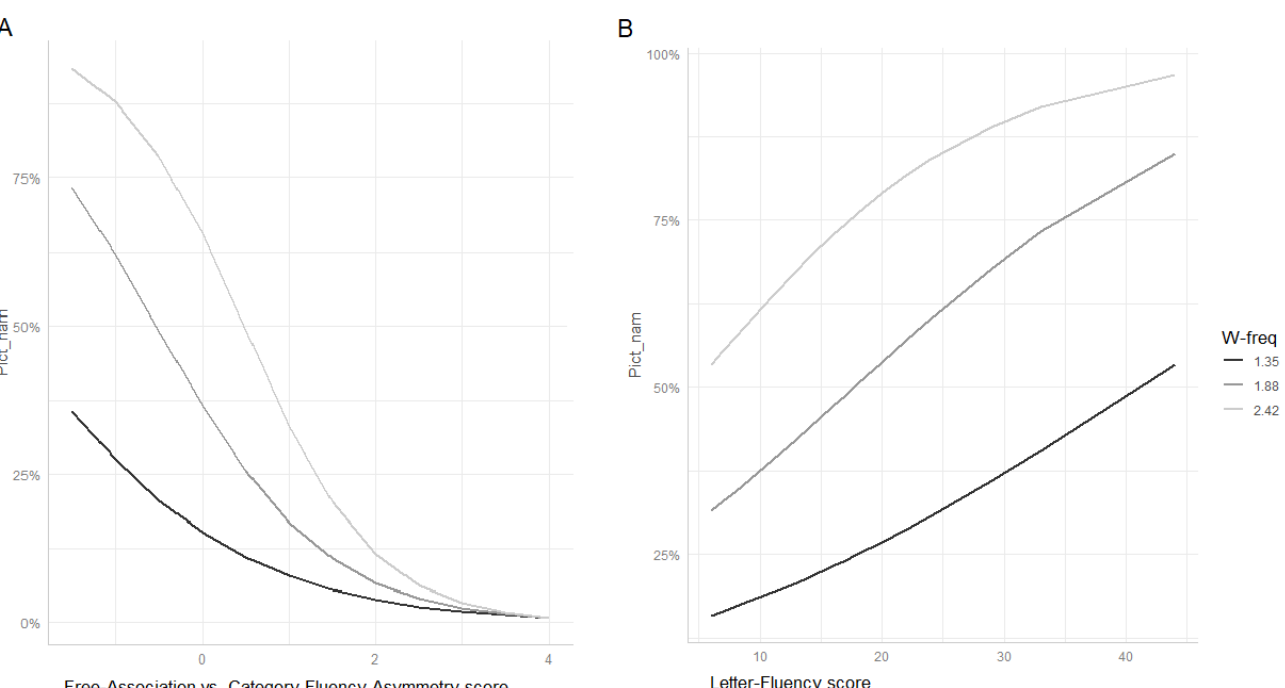
Figure 4. ( A ) Predicted probabilities of correct PN according to word frequency (mean ± SD) and F-associations vs. category-fluency asymmetry (mean ± SD). ( B ) Predicted probabilities of correct PN according to word frequency and letter fluency (the value of the covariate F-Assoc over which the effect is “averaged” and was lowered to -1SD (default = mean) to avoid confusing ceiling effects in the plots).